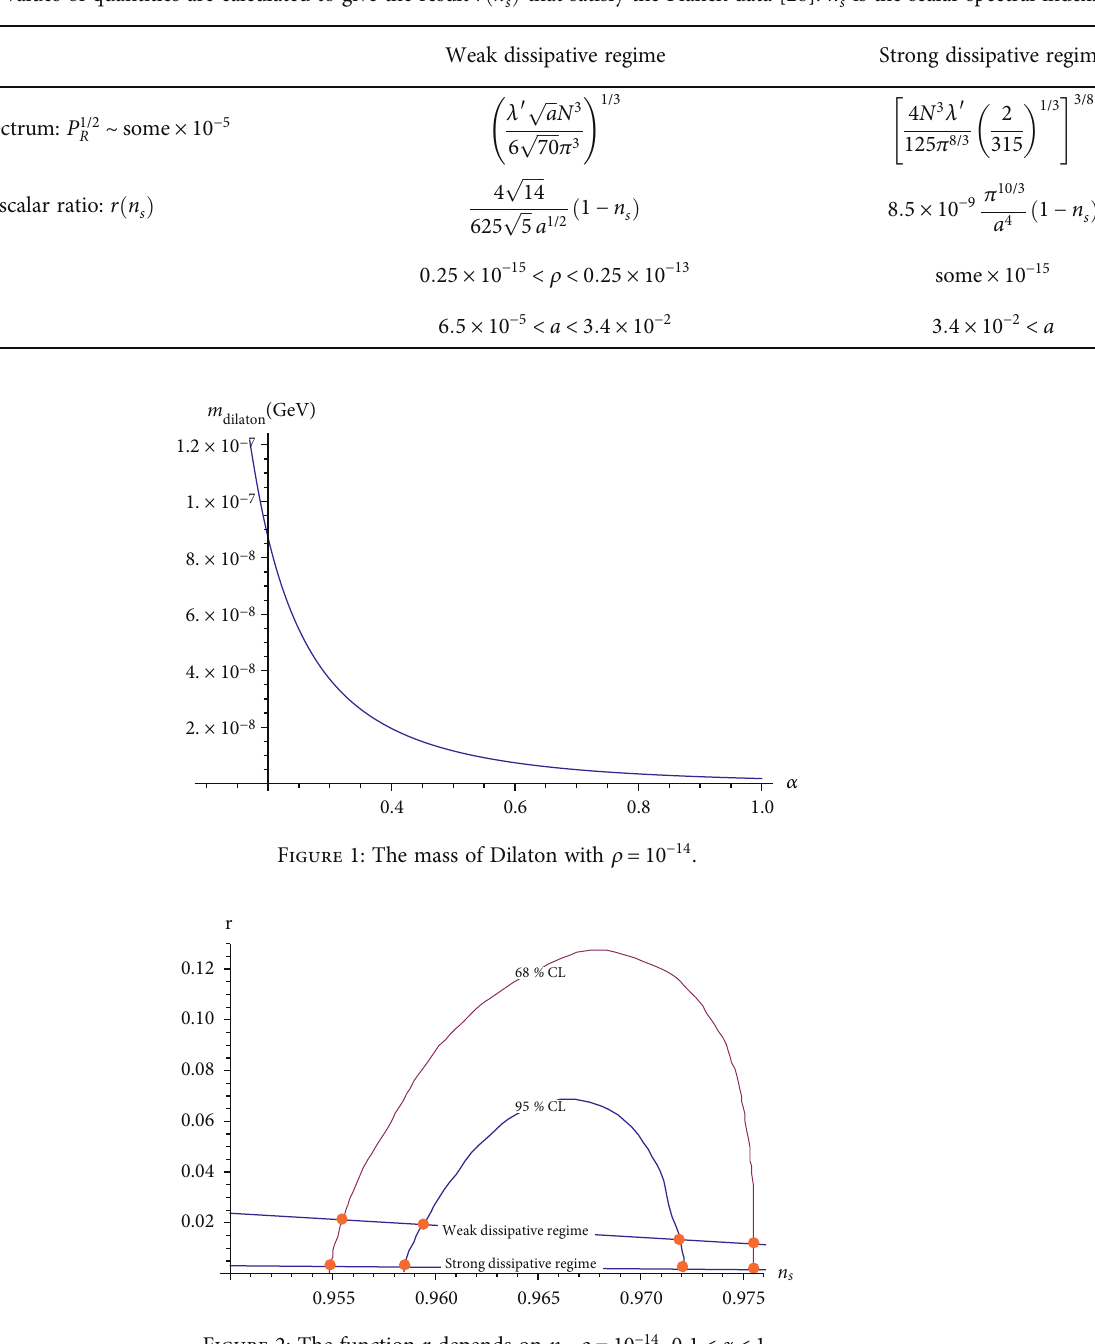
s is the scalar spectral index.